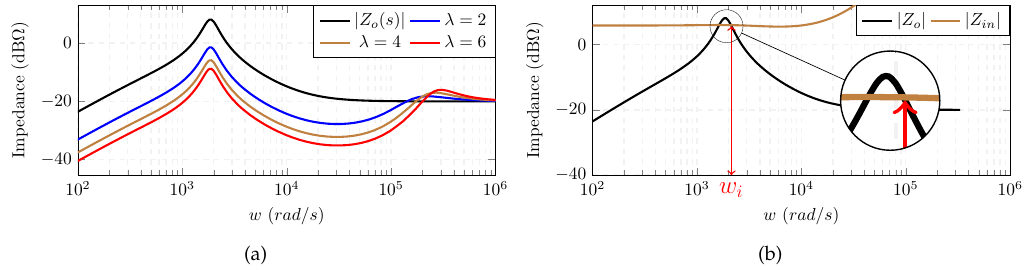
Figure 4. ( a ) The shaped output impedance magnitudes using a low-pass filter with ω c = 10 5 rad/s compared to the original output impedance